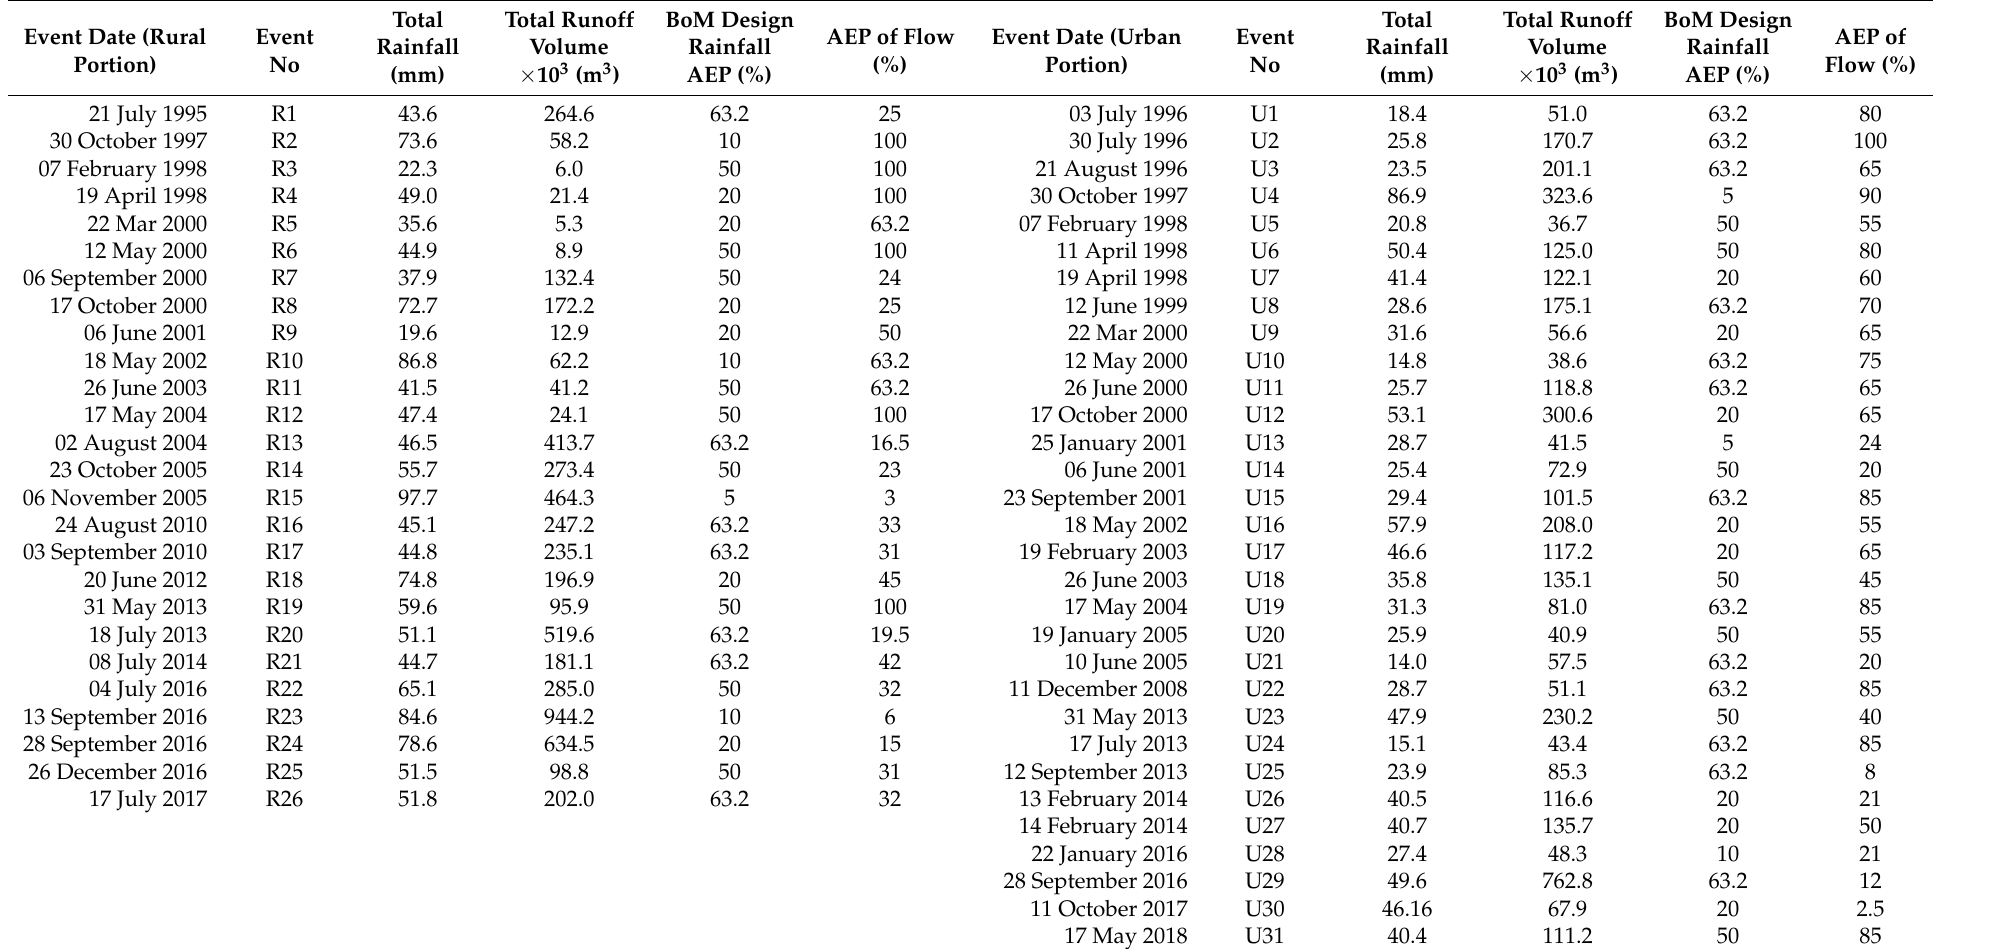
Table 3. Selected storm